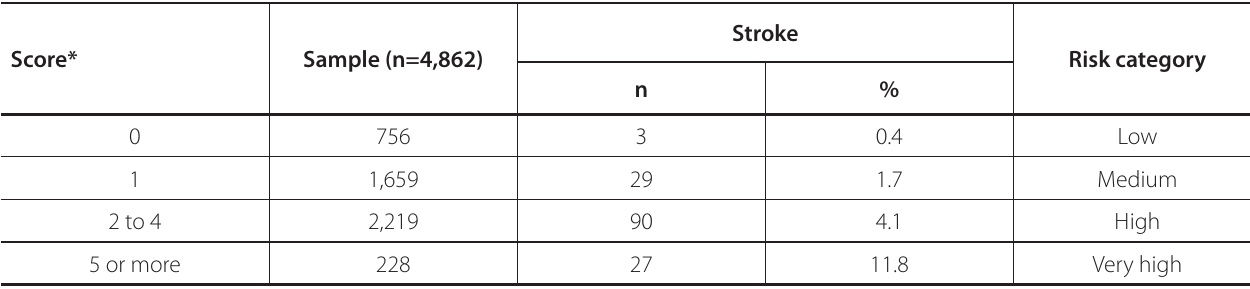
Table 4 . Risk of stroke according to the score (n=4,862).